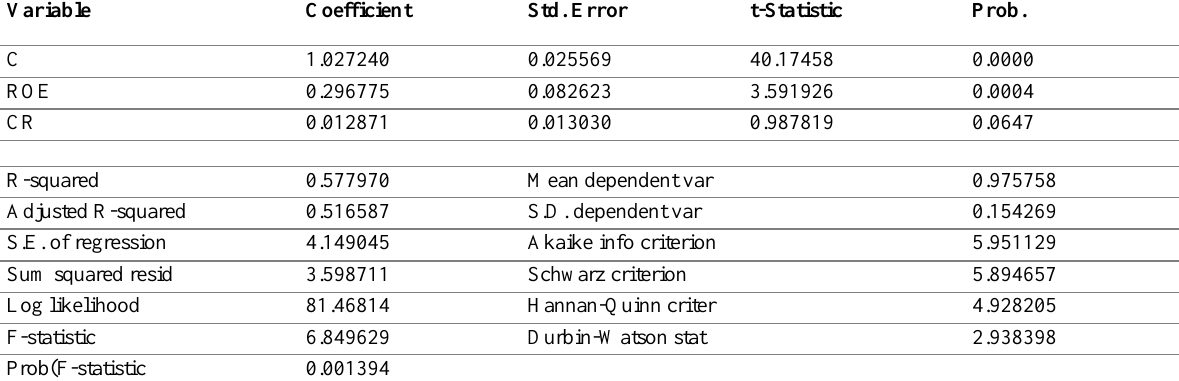
Table 1: Regression Results of Model I